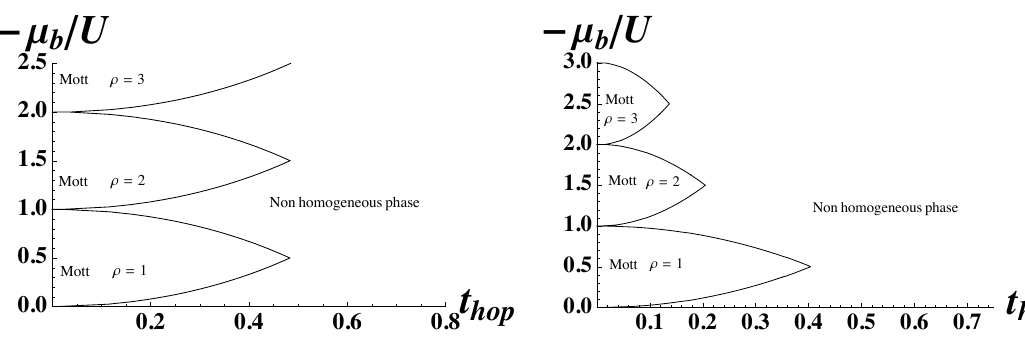
Figure 1 . The lobe-shaped phase structure of the holographic two-site model in the ( (cid:22) b ; t hop )-plane ((cid:3) = 1, u h = U = 40, and q = p 6 = 5). Left: for (cid:21) = w 2 = 1, and all (cid:3) ( p;r ) = 0. In the absence of IR interactions among the gauge (cid:12)elds and (cid:30) , the amplitude of the lobes is periodic under the shift (cid:22) b (cid:22) b + 1. Right: for (cid:21) = 1, w = 0, (cid:3) (1 ; 1) = 3 = 2 and other (cid:3) ( p;r ) = 0. We see the 1 =(cid:26) ! (cid:0) behavior of the phase